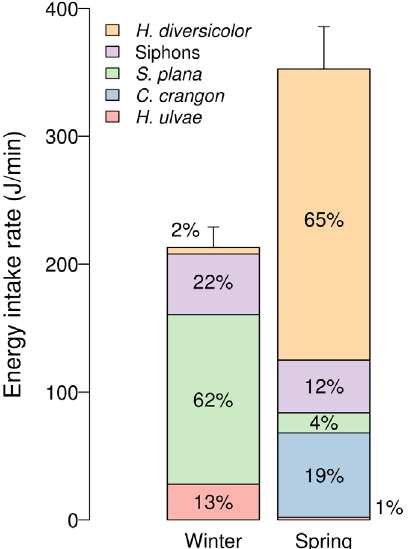
Figure 4. Mean energy intake rates achieved by foraging dunlins in winter and spring (J/min). Relative contribution of different prey is shown, as percentage. Error bars represent the SE for pooled